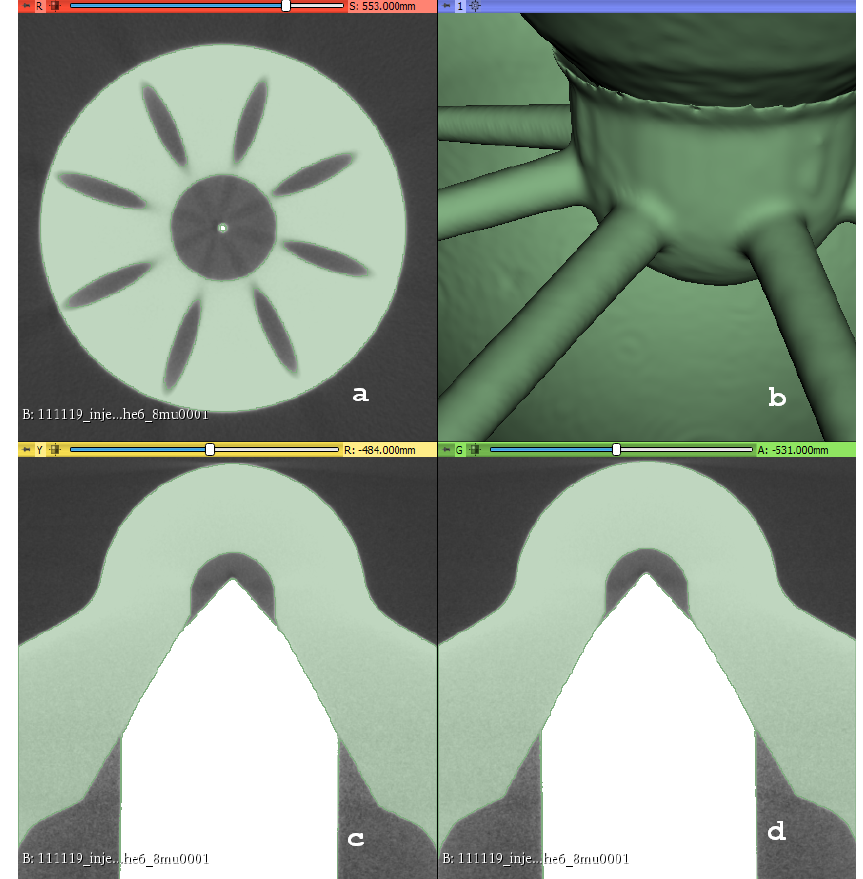
Figure 3. Cross section views of the aged injector’s nozzle tip and a reconstructed 3D model, representing the needle and the nozzle surfaces ( a ): images of the cross-sections in the injector nozzle area acquired from tomography. ( b ): reconstructed 3D nozzle and needle surfaces. ( c ) and ( d ): side cross section views of the needle and sac volume.